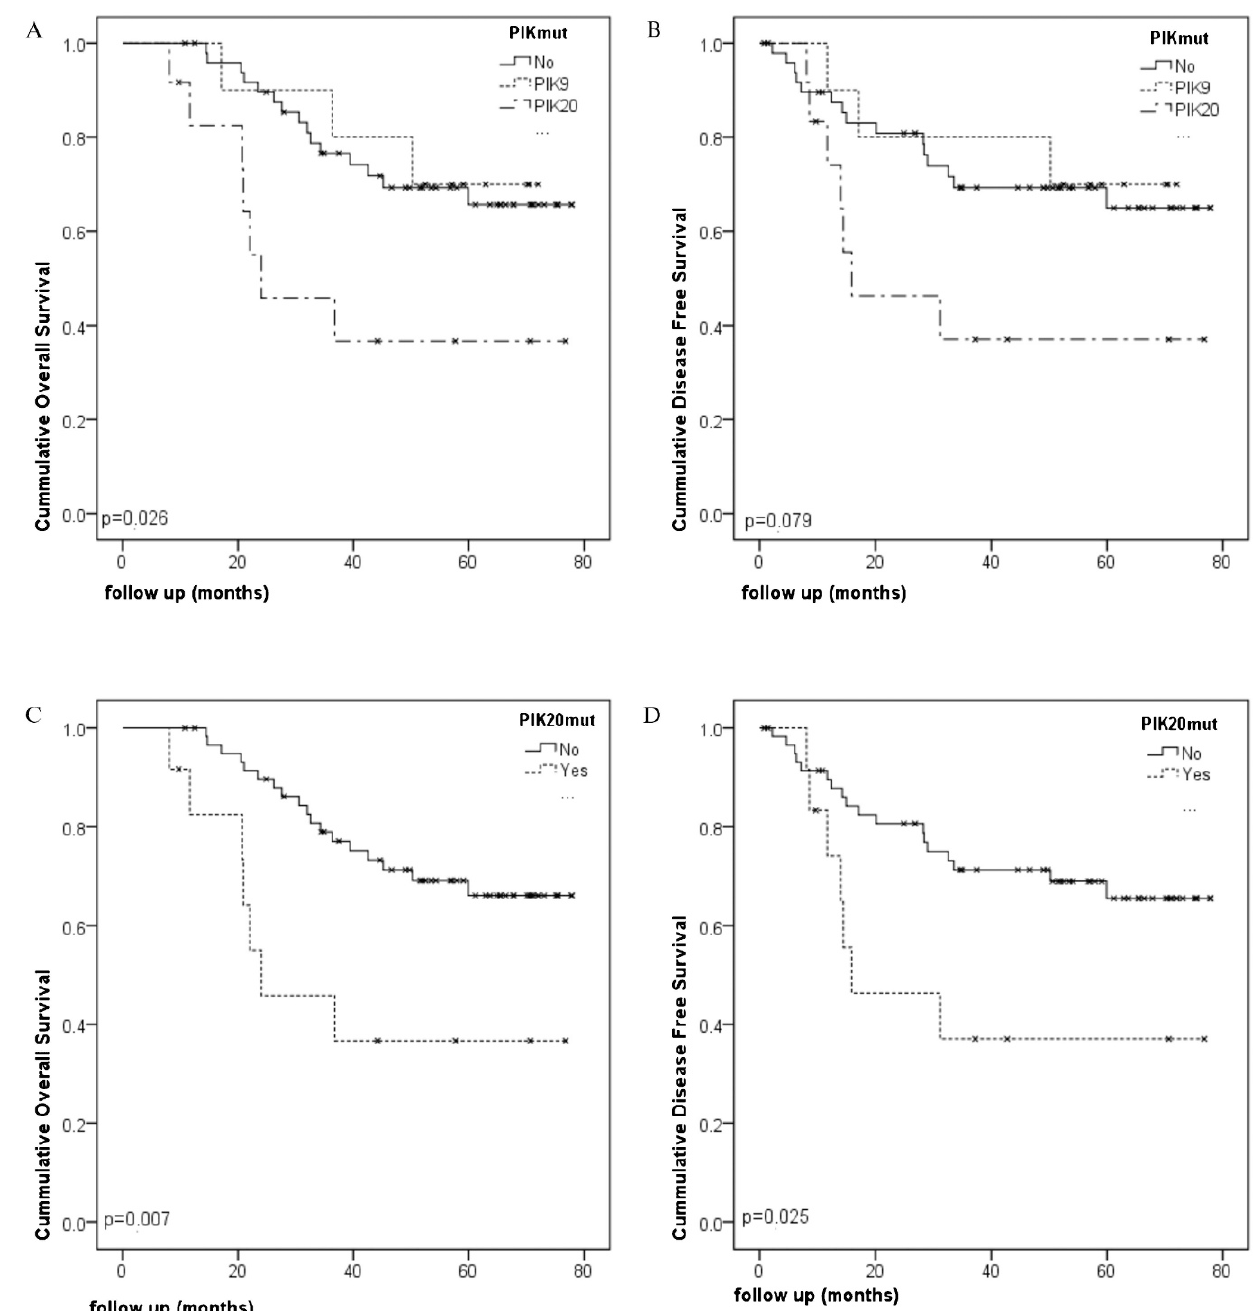
Figure 2 - Kaplan-Meier curves showing long-term survival in primary breast cancer patients, stratified according to PIK3CA mutation status. (A) Overall survival and (B) disease-free survival curves were calculated for the stratified patient groups. ‘No’ indicates patients with tumors with no PIK3CA mutations; ‘PIK9’ indicates patients with tumors with PIK3CA mutations in exon 9; and ‘PIK20’ indicates patients with tumors with PIK3CA mutations in exon 20. (C) Overall survival and (D) disease-free survival curves were calculated for the stratified patient groups. ‘No’ indicates patients with tumors with no PIK3CA mutations in exon 20, and ‘Yes’ indicates patients with tumors with PIK3CA mutations in exon 20. p -values were calculated using the